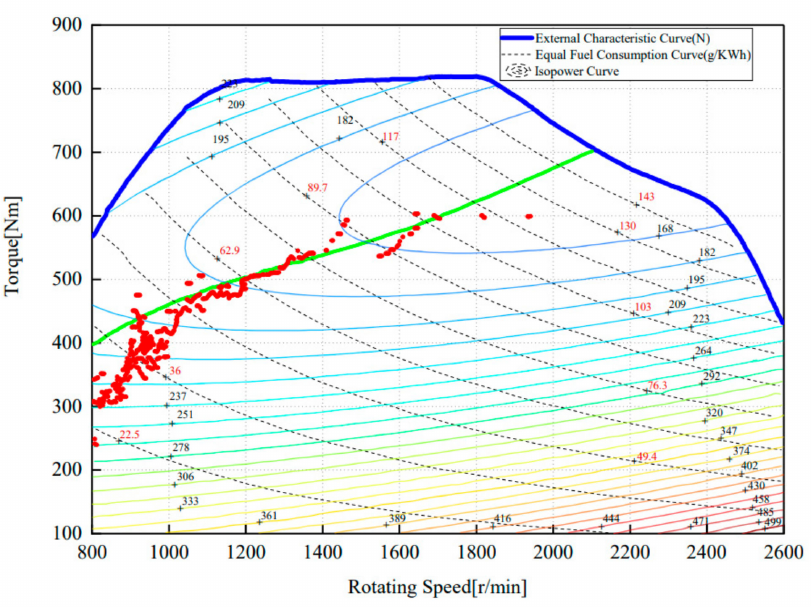
Figure 14. Working Point Distribution Map of the Engine Based on Dynamic